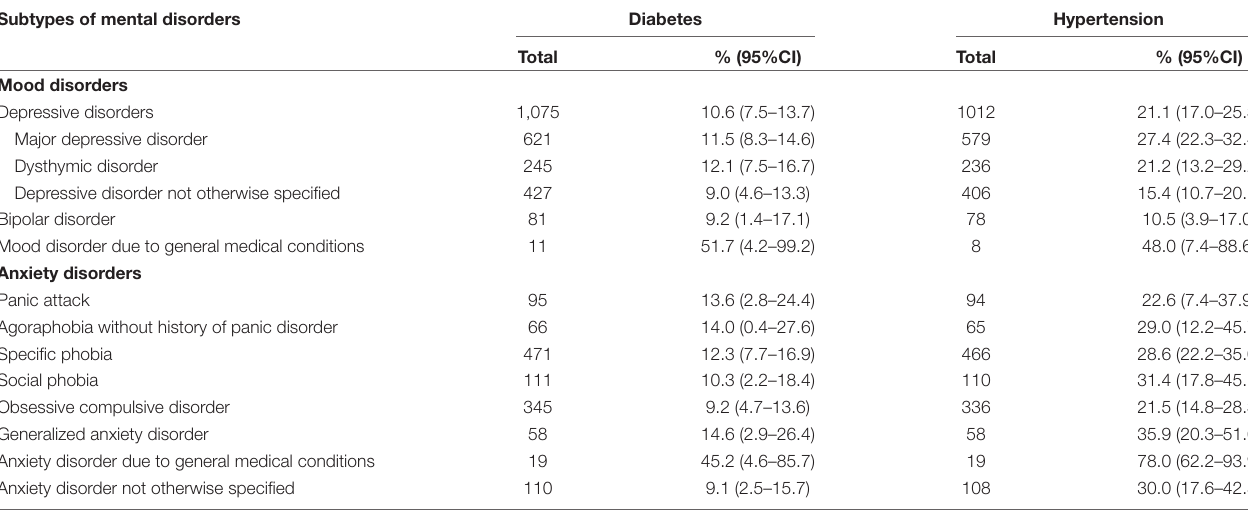
TABLE 2 | The weighted prevalence of diabetes or hypertension among patients with each subtype of mental